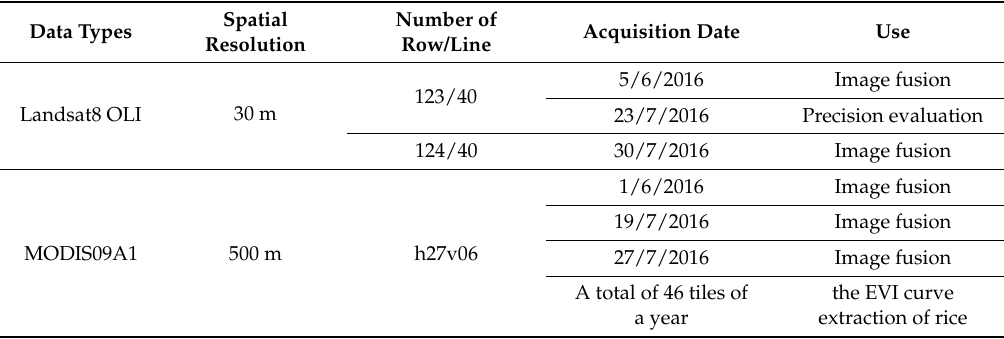
Table 1. Remote sensing data types and acquisition